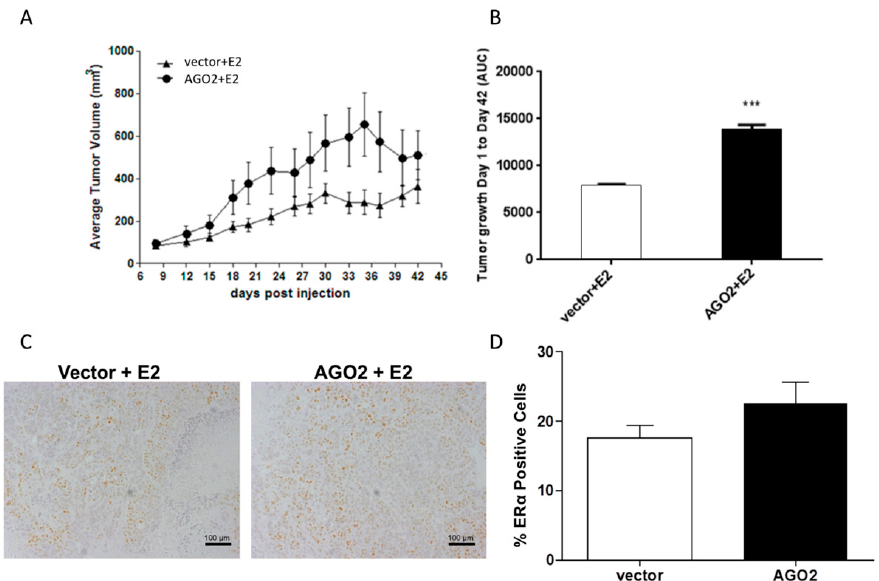
Figure 3. AGO2 enhances estrogen stimulated tumorigenesis in vivo. ( A , B ) Immunocompromised mice were inoculated with either 5 million MCF-7-vector or MCF-7-AGO2 cell lines in the presence of 60-day release estrogen pellet. ( A ) Results represent average tumor volume; ( B ) Results represent area under the curve (AUC). For all experiments error bars represent standard error of the mean (SEM), n = 10 for vector and n = 9 for AGO2 biological replicates. Significantly different *** p <0.001 ( C ) Tumors derived from MCF-7-AGO2 and MCF-7-vector inoculated mice were stained for ER α expression with immunohistochemistry, images obtained at 10 × magnification. ( D ) Graphical representation of ER α staining from tumor samples, error bars represent